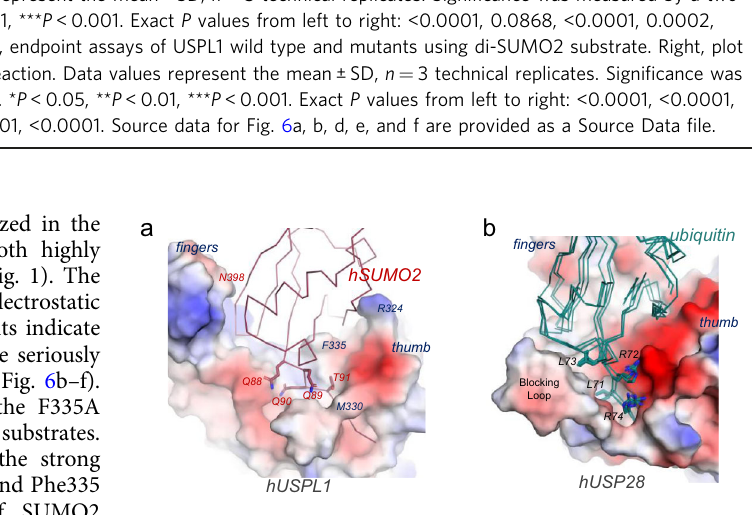
Fig. 6 Functional analysis of the SUMO2-USPL1 interface. a Left, activity assay of USPL1 with SUMO1-AMC and SUMO2-AMC. Middle, activity assay of Ubiquitin-AMC with USPL1 and USP28. Right, activity assay of SENP2 with SUMO1-AMC and SUMO2-AMC. Reactions were conducted in triplicate and the average curve is displayed. b Binding interaction of USPL1 point mutants with SUMO2-DHA. Reaction assays were conducted with USPL1 wild-type and mutants for 3 h. n = 3 technical replicates. c USPL1-SUMO2 complex structure shown in cartoon representation. USPL1 catalytic domain and SUMO2 precursor are shown in purple and red, respectively. USP right hand-like domains are labeled. Interface residues are labeled and shown in stick representation. Zinc atom is shown in yellow. d Left, activity assays of USPL1 wild type and mutants of the C-terminal tail interface using SUMO2-AMC. Middle, similar activity assays of USPL1 wild type and mutants of the thumb and fi ngers subdomains. Right, table indicating the mean slope values plus/ minus the standard deviation of the activity assays. n = 3 technical replicates. Signi fi cance was measured by a two-tailed unpaired t -test relative to wild- type. * P < 0.05, ** P < 0.01, *** P < 0.001. e Left, endpoint assays of USPL1 wild type and mutants using the RanGAP1-SUMO2 substrate. Right, plot of the RanGAP1-SUMO2 fraction after 10 min reaction. Data values represent the mean ± SD, n = 3 technical replicates. Signi fi cance was measured by a two-